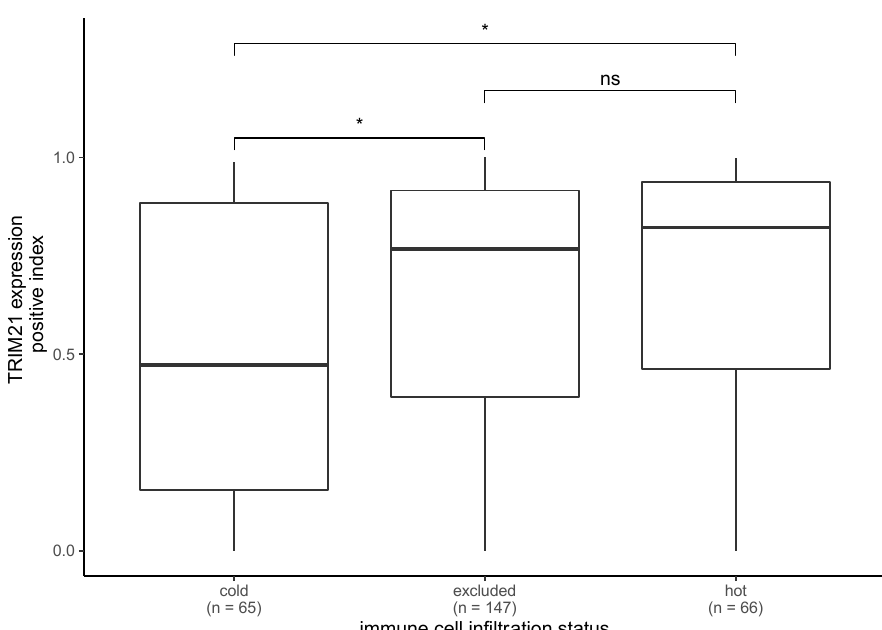
Figure 5. TRIM21 expression in primary tumors regarding immune cell infiltration. There were significant differences in the TRIM21 expression between cold and excluded primary tumors (Mann– Whitney test, p = 0.02) and between hot and cold primary tumors (Mann–Whitney test, p = 0.011). (* p < 0.05, ns = not significant).